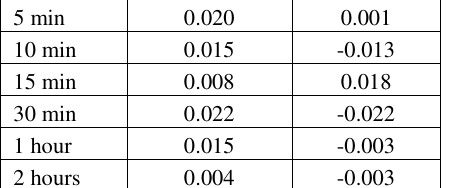
Table 3. Deviations in horizontal and vertical for T002.